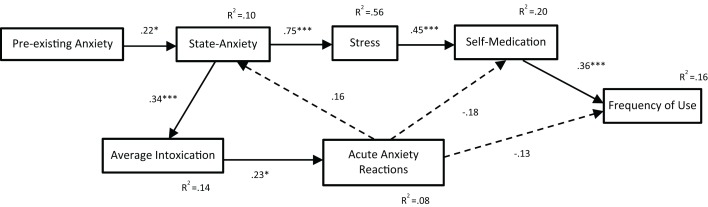
Path analysis of Model 3. With the exception of noted R2 values, all values are standardized regression weights (β), dashed lines indicate non-significant associations. Model fit: χ2(12) = 9.96, p = 0.620; TLI = 1.027; CFI = 1.000; RMSEA = 0.000 (0.000, 0.089). *p < 0.05, **p < 0.01, ***p < 0.001.